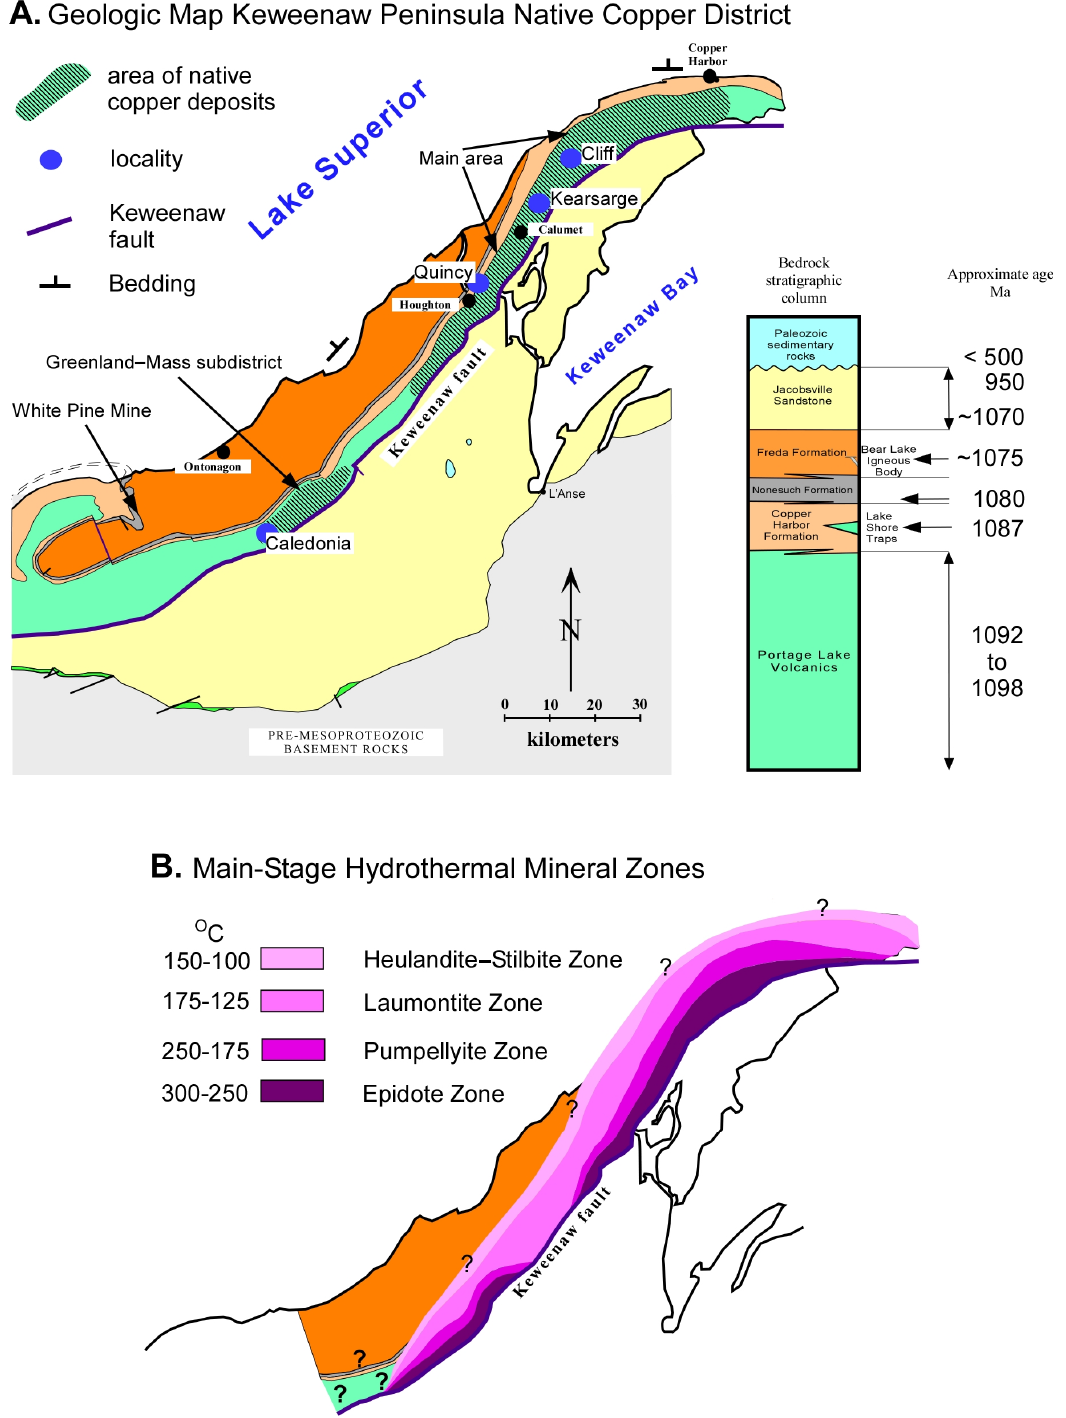
Figure 2. ( A ) Bedrock geologic map of the Keweenaw Peninsula native copper district showing the main-area of native copper deposits and the Greenland-Mass subdistrict, which is a smaller area hosting native copper deposits. The district extends to the White Pine Mine where late-stage native copper cross cuts the shale-hosted diagenetic chalcocite deposit. Sampling localities shown with blue dot, towns with black dot. ( B ) Map showing main-stage hydrothermal mineral zones and temperatures discussed in the text. The Jacobsville Sandstone is not shown since the main-stage hydrothermal/metamorphic event pre-dated deposition of surface exposures. Modified from Bodden [18].